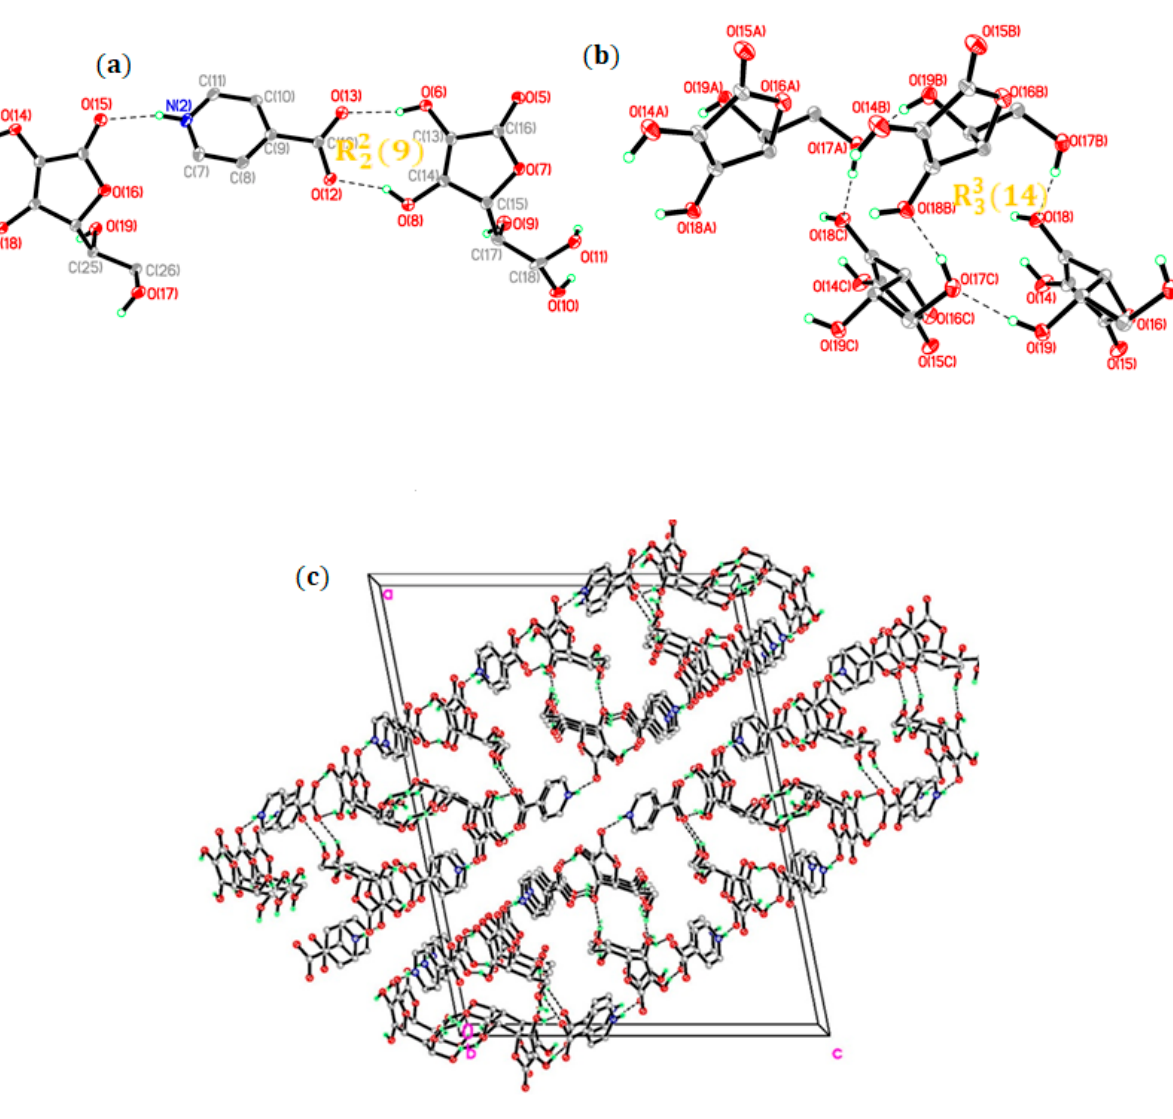
Figure 1. Hydrogen-bonded pattern among ( a ) Type I, ( b ) Type II and ( c ) 2D ribbon in VC-INA.